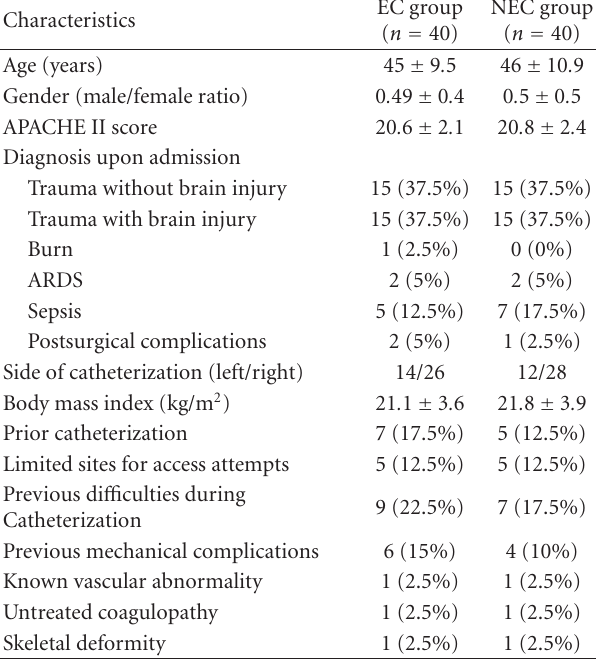
Table 1: Baseline characteristics of the study population; values are presented either in percentages or as mean ± SD.